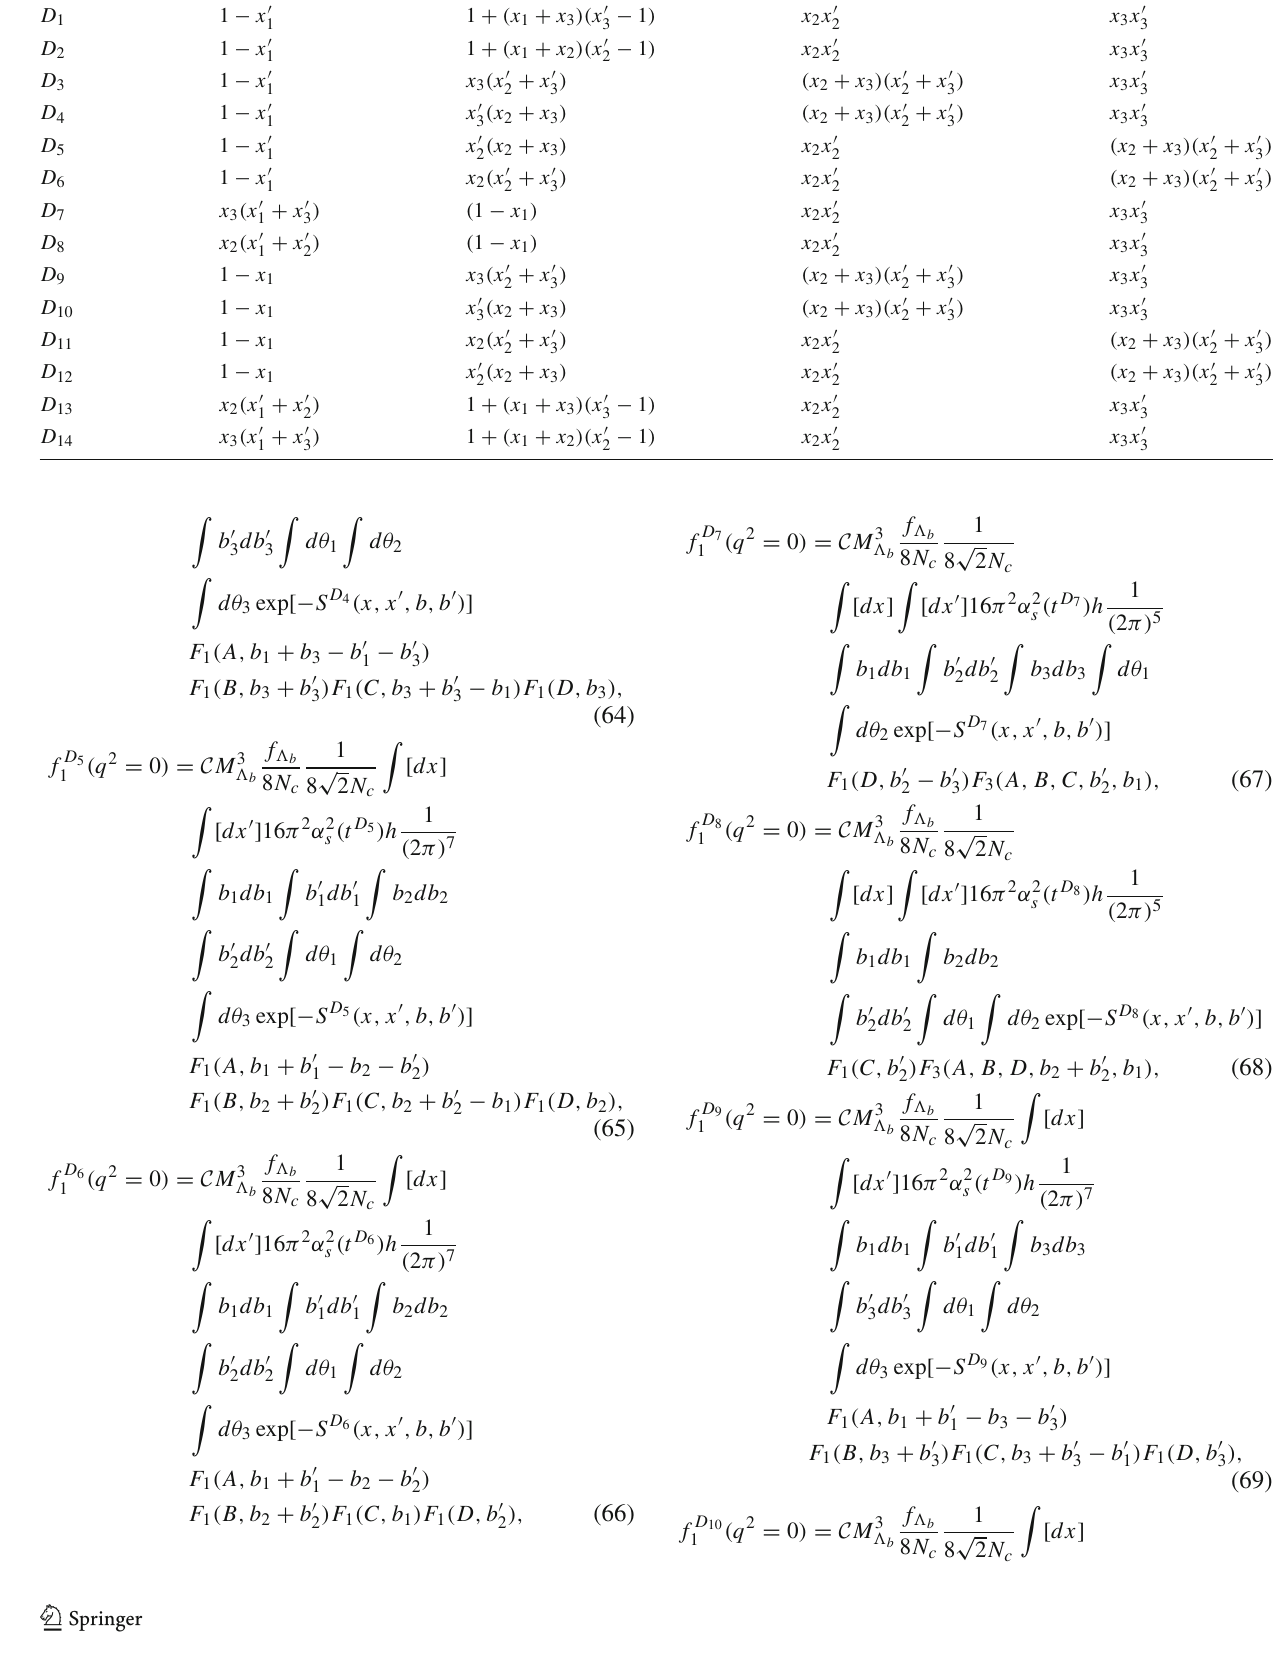
is implicit for the b